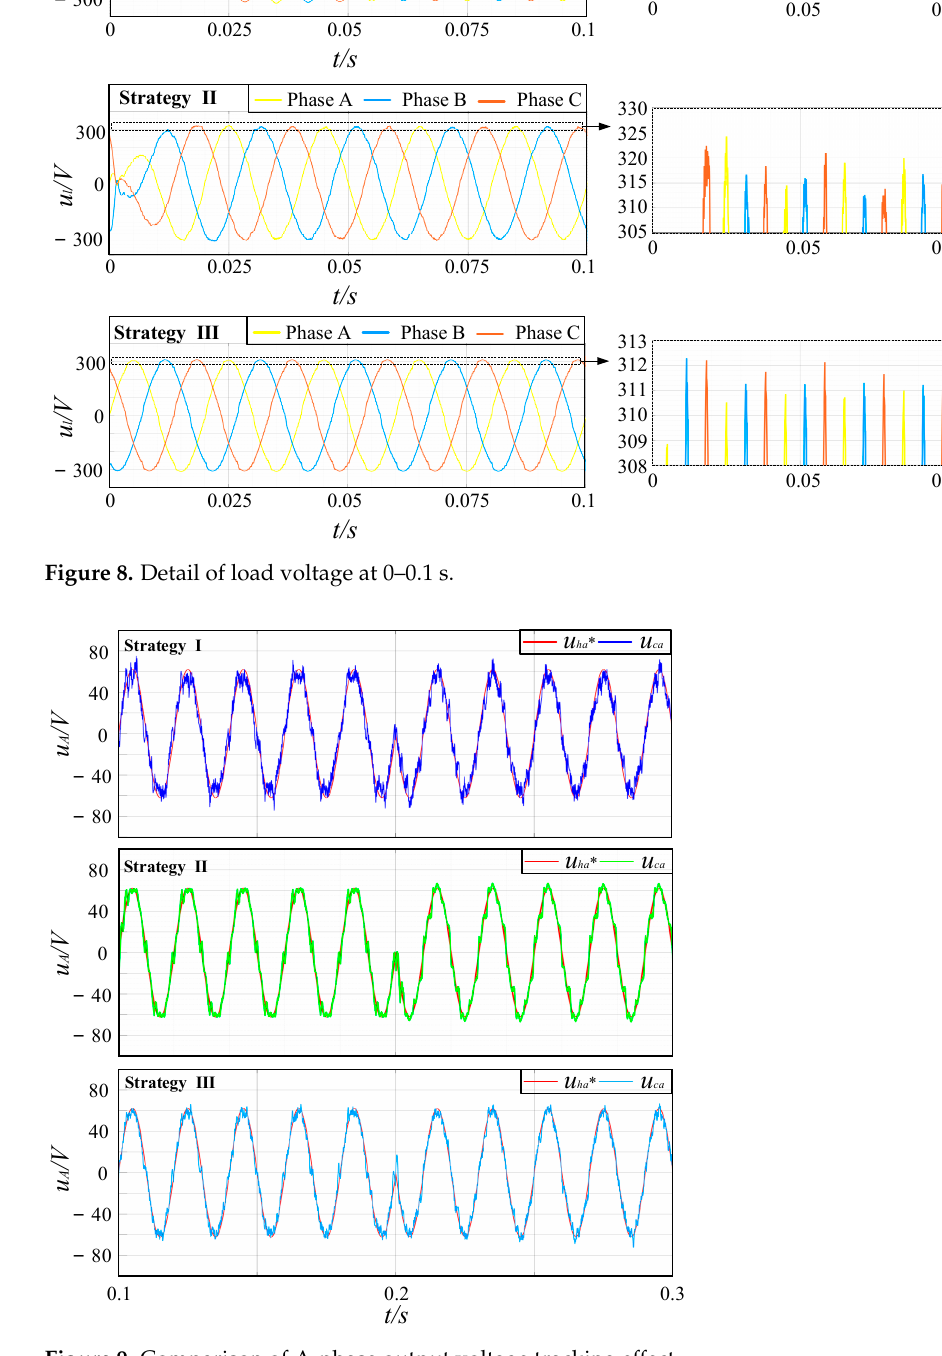
Figure 9. Comparison of A-phase output voltage tracking effect.